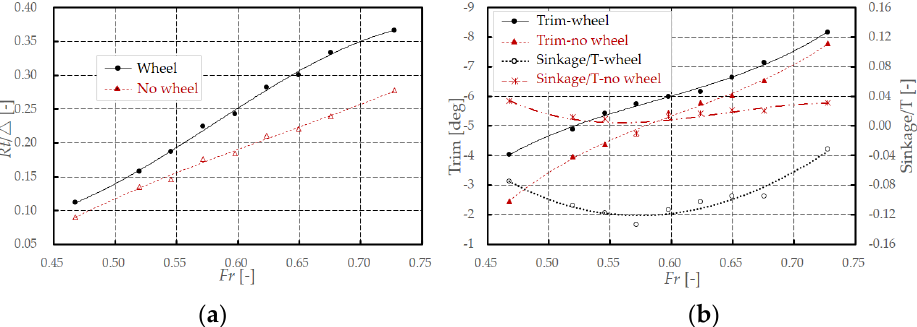
Figure 9. The simulation results of the bare vehicle with and without wheels. ( a ) The resistance of the bare vehicle with and without wheels; ( b ) The attitude of the bare vehicle with and without